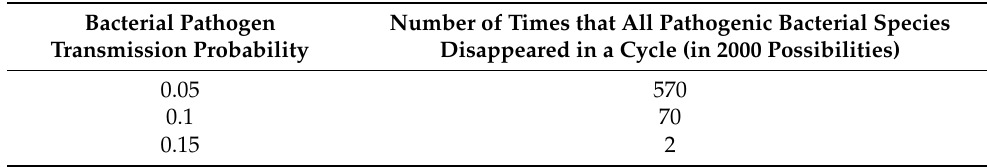
Table 4. Simultaneous extinction of all pathogenic bacterial species according to the bacterial pathogen transmission